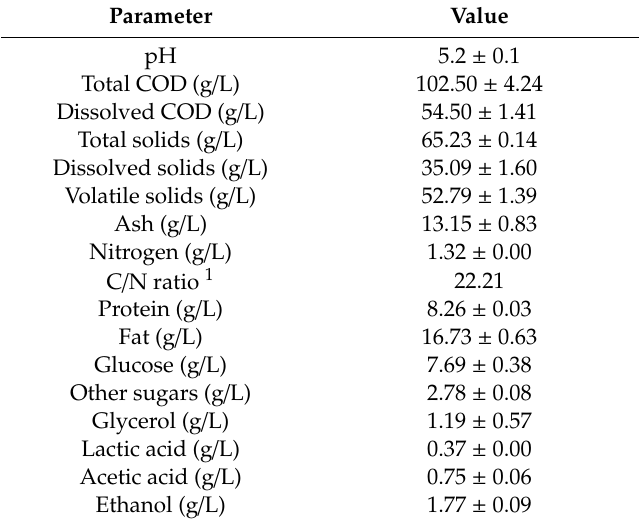
Table 1. Characterization of OMWW used in the